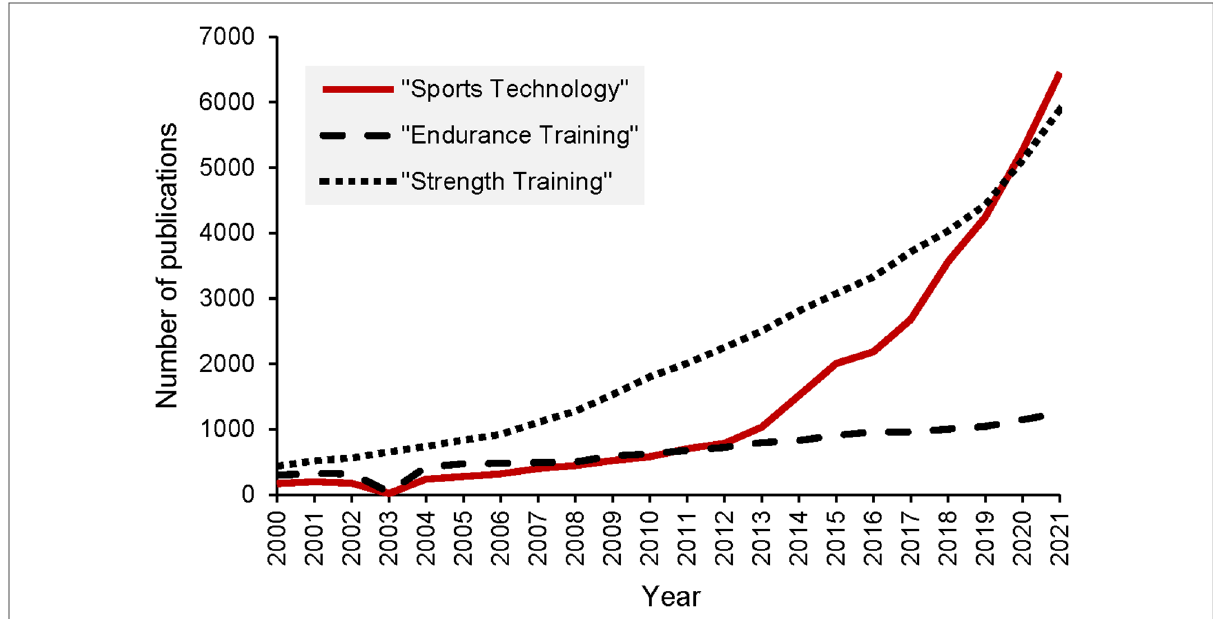
FIGURE 1 Number of publications for “ Sports Technology ” , “ Endurance Training ” and “ Strength Training ” in Pubmed.gov as of